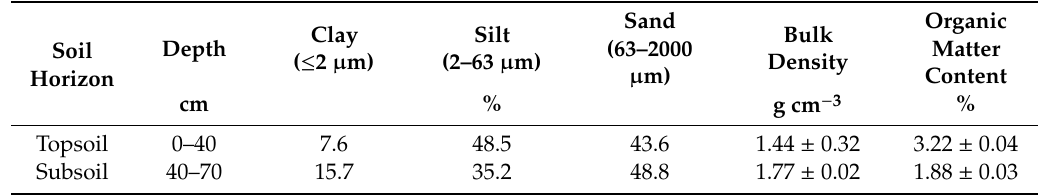
Table 1. Soil physical properties of the soil at the study